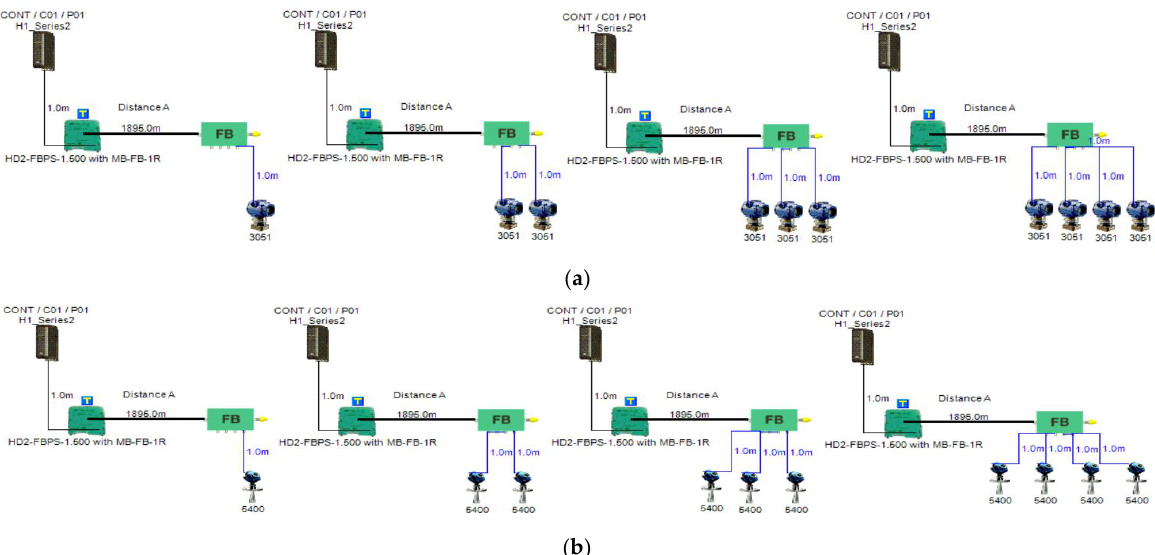
Figure 6. Test segments ( a , b ) dedicated to deriving the relation between main FF trunk cable length and current consumed by field barriers. ( a ) Test segments using Rosemount 3051 Pressure Transmitters; ( b ) Test segments using Rosemount 5400 Radar Transmitters.